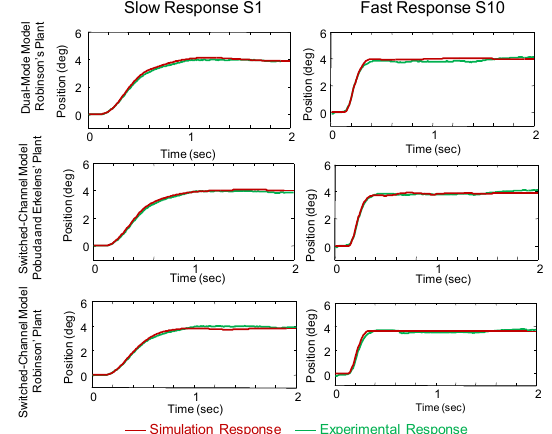
Figure 4: Comparison of slow and fast position responses using dual-mode and switched-channel models with plants described by either Robinson or Pobuda and Erkelens. The model simulations are plotted as red lines and are compared with typical experimental vergence responses to 4  step stimuli selected from the response ensembles shown in Figure 3 (green lines). Comparisons are shown for both subject S1 who had the slowest average peak velocity and subject S10 who had the fastest average peak velocity of all subjects studied. The dual- mode model simulations using Robinson’s plant are shown in the upper plots. The switched-channel model using Pobuda and Erkelens’ original plant and Robinson’s plant are shown in middle plots and lower plots, respectively. Both models with either plant can represent the experimental responses.